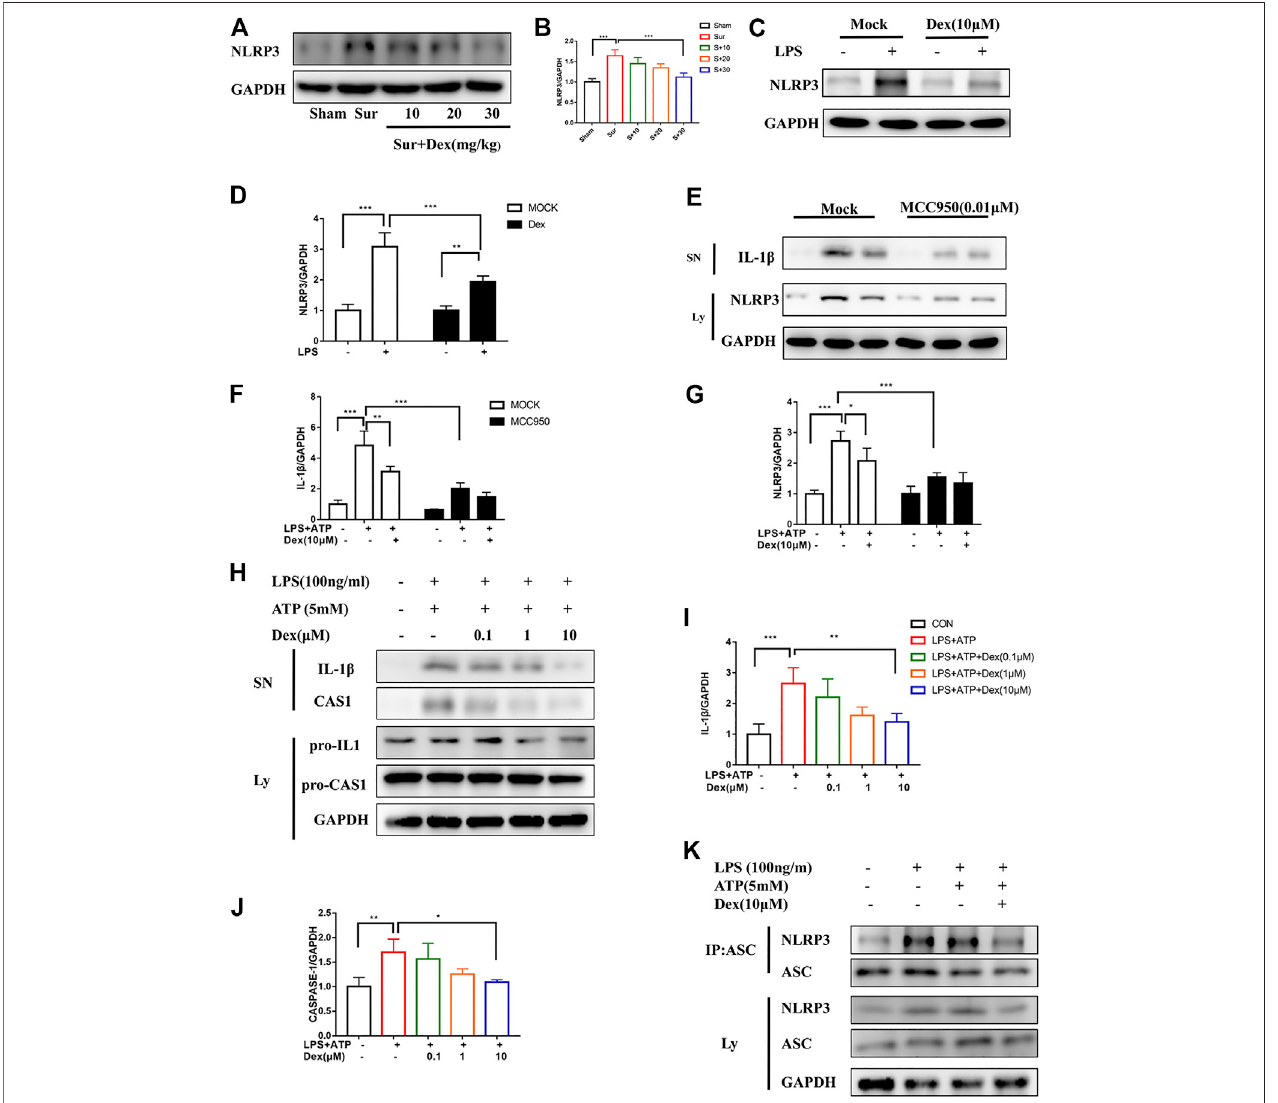
FIGURE 4 | DEX suppressed CASP1 and IL-1 β maturation by interrupting NLRP3 in fl ammasome activation and assembly. Protein NLRP3 in the hippocampus brain region of different groups of mice was detected by Immunoblotting (A,B) is the corresponding statistical analysis (means ± SEM, n (cid:1) 4). LPS-primed primary microglial cells were incubated with DEX for 5 h, and NLRP3 expression was detected via Immunoblotting (C) , and the data shown in (D) (means ± SEM, n (cid:1) 4). Primary microglial cells were treated as follows: MCC950 (0.01 μ M) was administered 2 h in advance, LPS-primed primary microglial cells were incubated with DEX for 5 h and then ATP was gived for 30 min. The protein cell supernatant protein and cytosolic protein were collected for Immunoblotting to detect IL-1 β and NLRP3 (E) . The data is shown in (F,G) (means ± SEM, n (cid:1) 4). The expressionofthepro-IL-1 β /IL-1 β ,pro-CASP1/CASP1examinedbyImmunoblotting (H) ,thecellsofthetreatmentisthesamewayasabove.Proteinexpressionanalysis datawereshown in (I,J) (means ± SEM, n (cid:1) 4).TheNLRP3-ASCinteraction wasanalyzedbyCO-IPandImmunoblotting (K) .Alltheabovedataanalysiswerepresented asthemeans ± SEM, p < 0.05isde fi nedasstatistically different,and thensmeansnosigni fi cance, * p < 0.05,** p < 0.01,*** p < 0.001comparedwiththecorresponding group. The data analysis in (B,I,J) was one-way ANOVA, data analysis in (D,F,G) was two-way ANOVA. SN, supernatant; Ly, lysate.